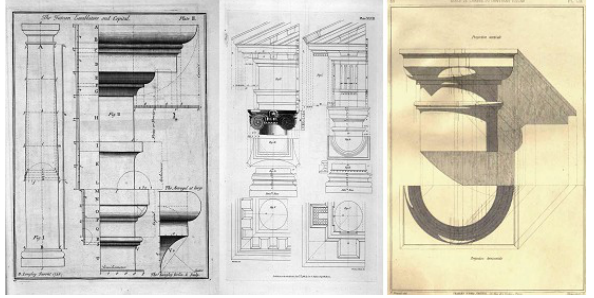
Figure 2 Example of pattern book